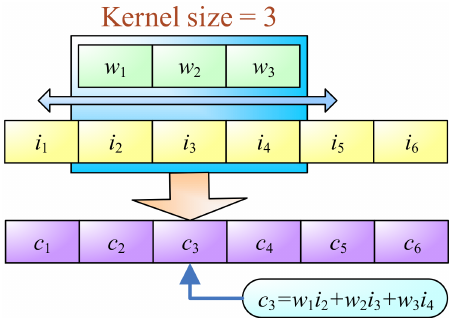
Figure 3. Calculations involved in a 1D convolution operation.